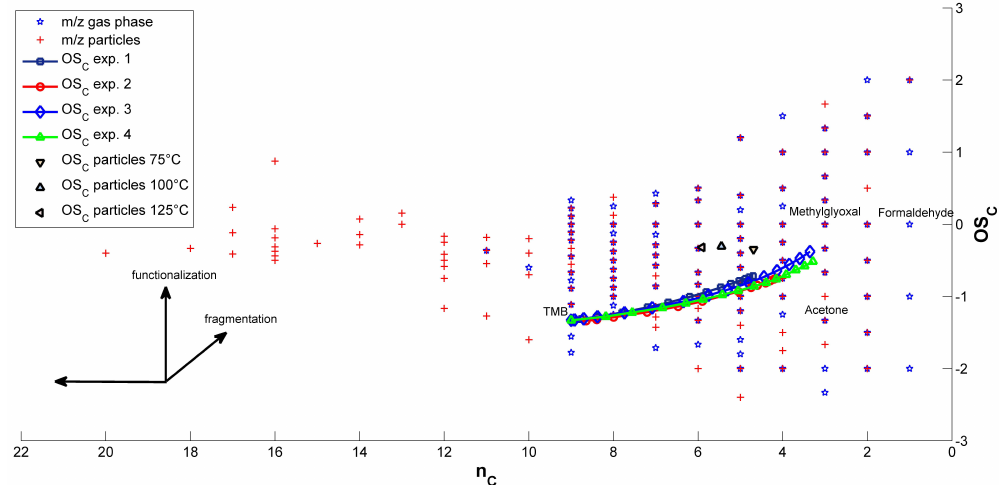
Fig. 10. Data from the first 7h of gas-phase measurements (experiments 1a, 2, 3 and 4) and SOA measurements (experiment 1b) depicted in the OS C - n C space. Blue stars depict the OS C - n C position of all detected m/z signals measured in the gas phase and red crosses indicate all m/z signals detected in the SOA study. Solid lines indicate the evolution of the average OS C during the course of the photo-oxidation experiments. Black symbols show the average OS C in the particle phase as measured at different desorption temperatures (experiment 1b).